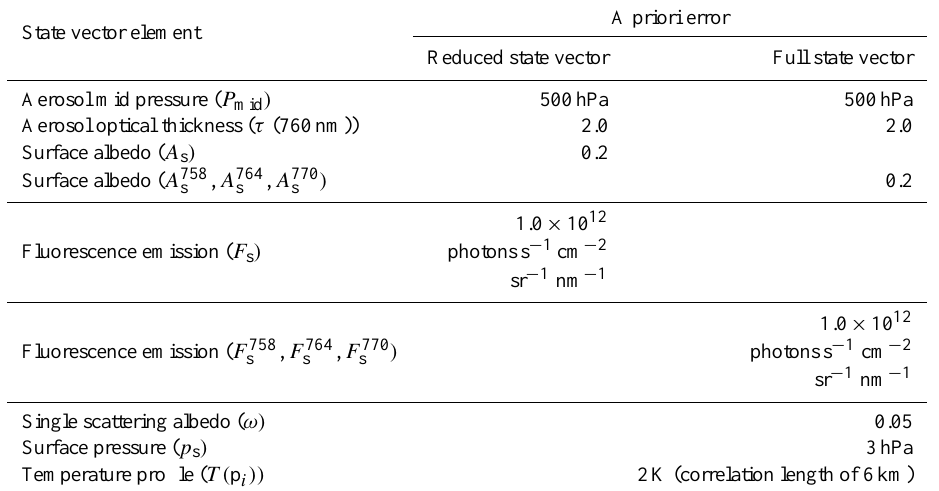
Table 1. State vector elements and a priori errors used for calculating retrieval precision. For retrieval of the reduced state vector, the measurement error covariance matrix comprises noise errors, and the surface albedo and fluorescence emissions are assumed constant across the fit window. For retrieval of the full state vector, the measurement error covariance matrix comprises noise and calibration errors, and the wavelength dependence of the surface albedo and fluorescence emissions in retrieval is described by a second-order polynomial (three wavelength